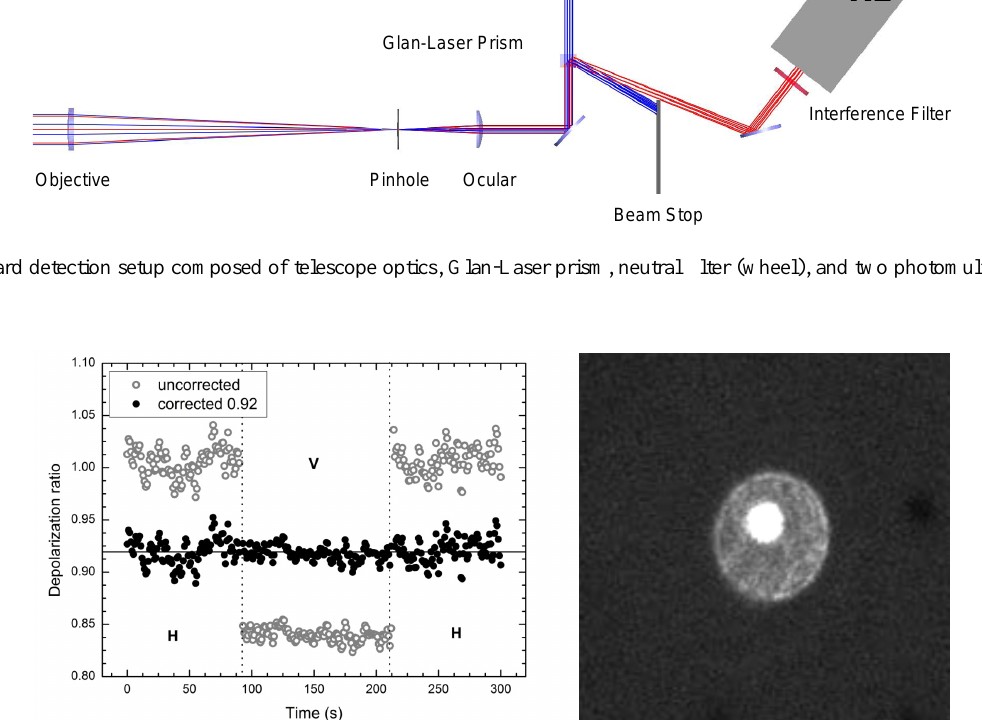
Fig. 4. Left: adjustment cycle for the backscattering photomultiplier signals using a Spectralon scattering target. A tuning factor of 0.92 was utilised in the R1 signal in order to get the same depolarisation ratio of 0.92 for parallel (H) and perpendicular (V) incident polarisation. Note that the R1 photomultiplier detects I ⊥ in case of parallel and I k in case of perpendicular incident polarisation. Right: overlap between the SIMONE laser beam (small bright spot) and the illuminated detection aperture on the scattering target. Note that this photo was taken by a CCD camera equipped with a zoom objective that is permanently installed at the AIDA chamber for routine checks of the SIMONE